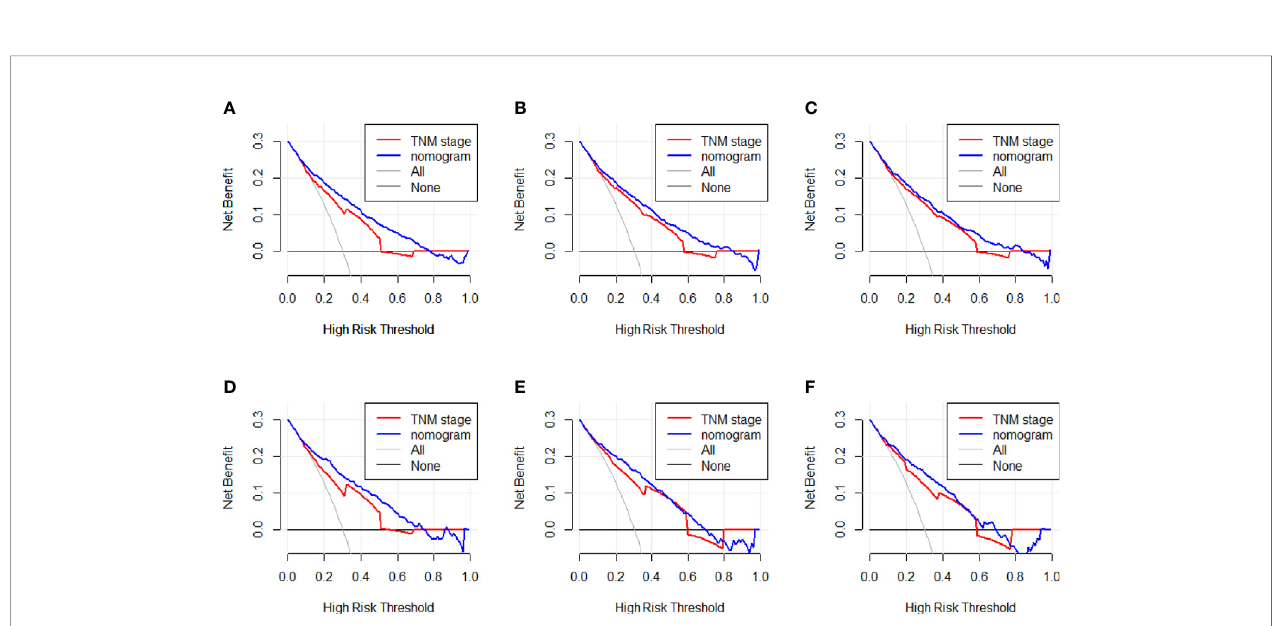
FIGURE 4 | (A – C) Nomogram and AJCC staging system ROC curves for predicting 1-, 3-, and 5-year OS in the training cohort. (D – F) Nomogram and AJCC staging system ROC curves for predicting 1-, 3-, and 5-year OS in the validation cohort.